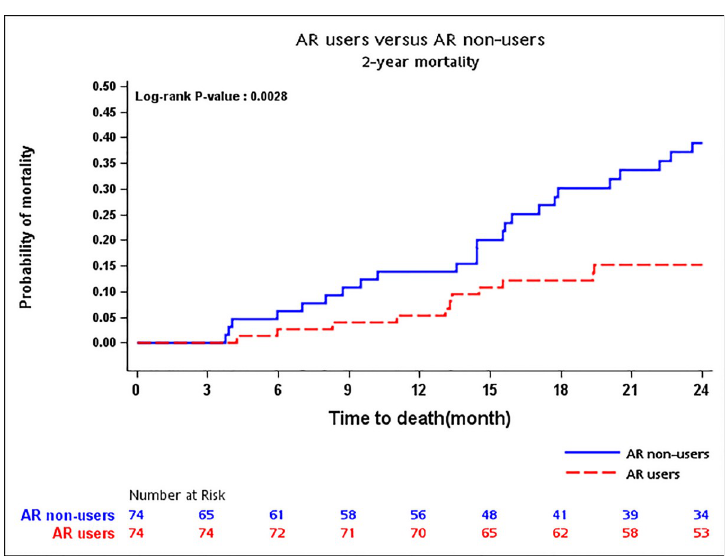
Fig 3. Two-year cumulative mortality rate between AR non-users and AR